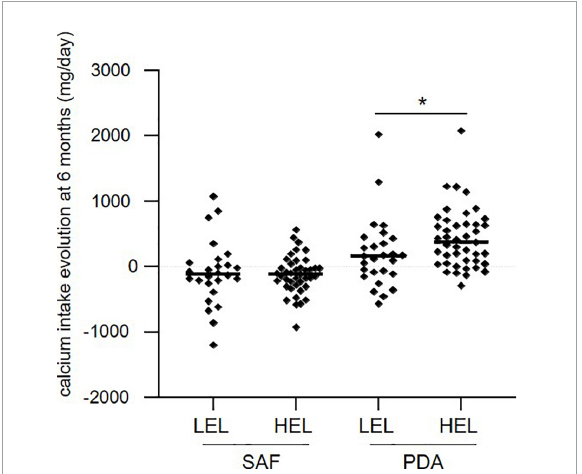
FIGURE4 Evolution of calcium intake at 6 months in each group, according to the level of education. LEL, low education level; HEL, high education level. Means are shown as horizontal bars. Statistical significance was determined using the Wilcoxon–Mann–Whitney test. * p <